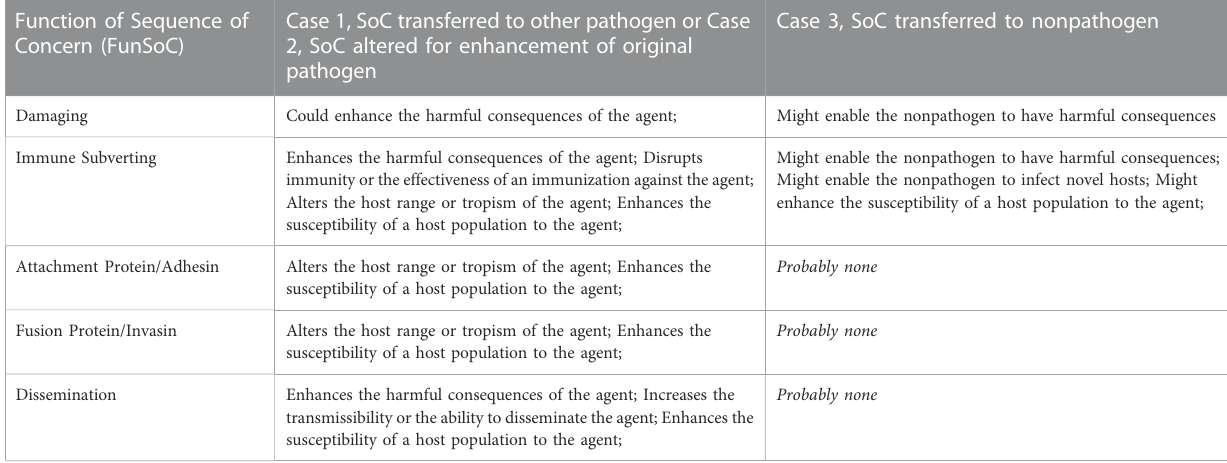
TABLE 6 How work on SoCs could correlate with DURC categories. Function of Sequence of Concern